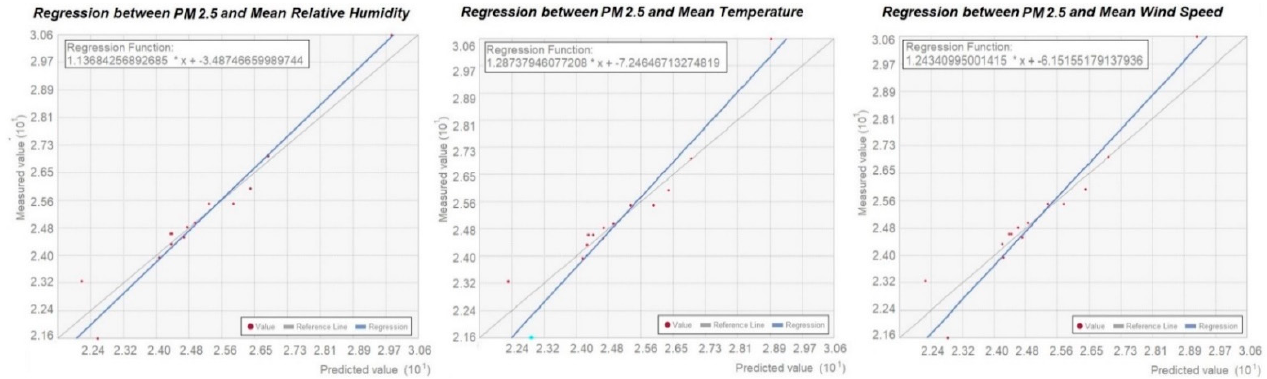
Figure 9. Regression analysis between PM 2.5 and temperature, wind speed and relative humidity . Table 7. Table of errors in PM 2.5 stations (µg/m 3 ) . Station Measured PM 2.5